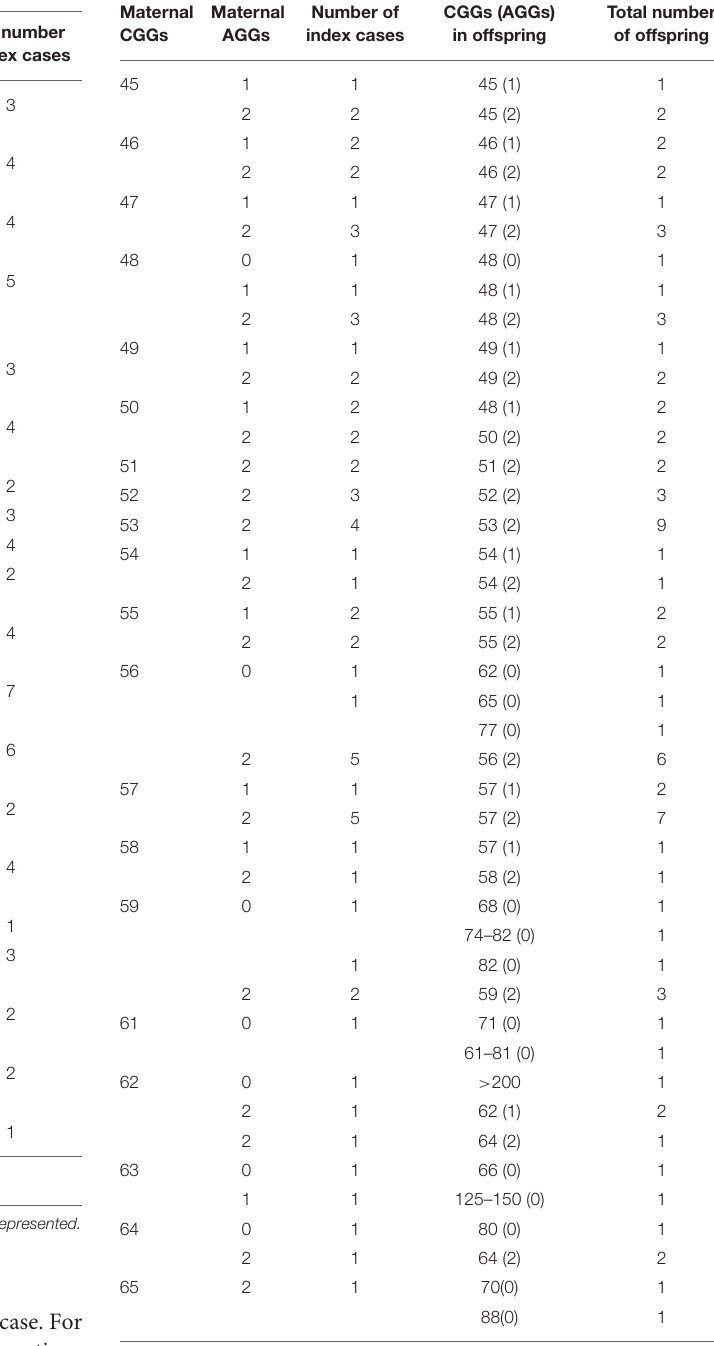
TABLE 2 | Transmissions of the alleles between 45 and 65 CGG repeats. Maternal Maternal Number of CGGs AGGs index